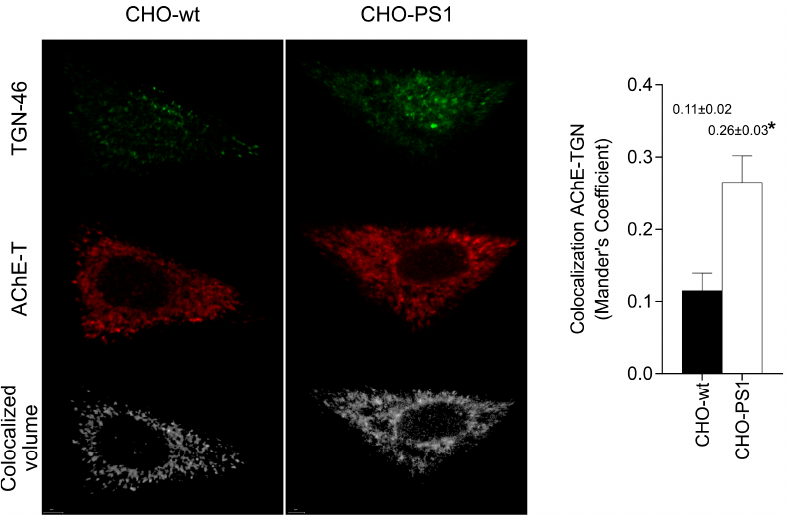
Figure 4. Localization of AChE ‐ T variants in the trans ‐ Golgi network is increased in Chinese hamster ovary cells overexpressing presenilin ‐ 1 (CHO ‐ PS1) as compared to wild ‐ type (CHO ‐ wt). CHO cells were transfected with plasmid cDNAs that encode AChE and PRiMA to increase the expression of cholinergic tetrameric AChE. Immunoassay for the trans ‐ Golgi network marker (TGN ‐ 46) and AChE ‐ T variant was performed, and images were obtained using a confocal microscope with the ×63 oil immersive objective lens and subsequently analyzed with the Imaris software for colocalization. Representative images of three experiments are shown (CHO ‐ wt, scale bar = 3 μ m; CHO ‐ PS1, scale bar = 2 μ m). At the bottom, co ‐ localization volume showing pixels positive for both AChE ‐ T and TGN46 marked in white. To the right, quantification of Mander’s coefficient of colocalization. Values are means ± SEM from at least of 12 independent determinations from two independent experiments. * indicates exact p value < 0.05 when applying Mann–Whitney test.